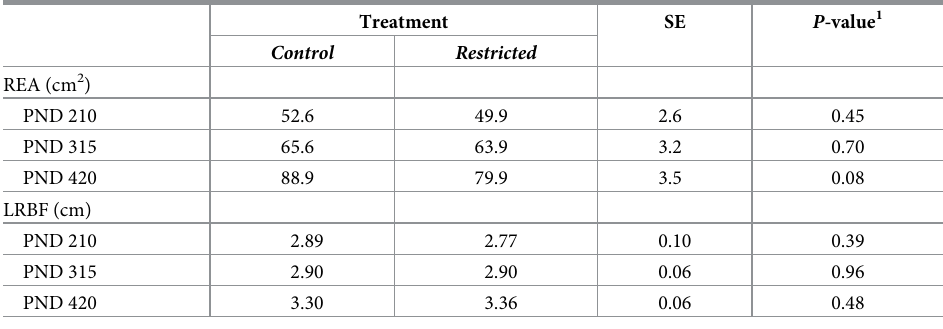
Table 3. Effects of maternal nutritional energy restriction (100% vs 70%) from GD 158 to parturition on REA and LRBF of Angus cross offspring fed ad libitum from PND 315 to PND 485 (n = 9 per treatment). Treatment SE P -value 1